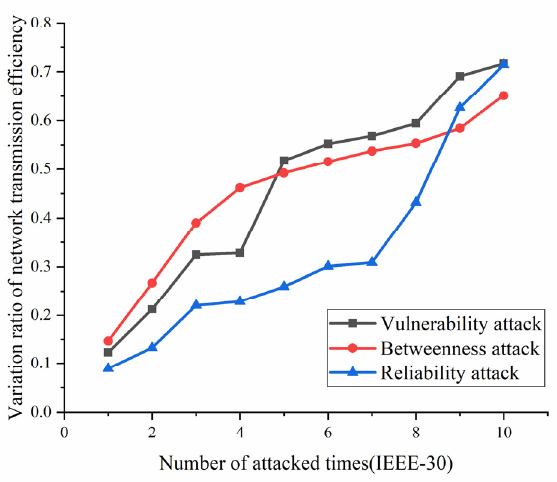
Figure 22. Variation ratio of network transmission efficiency of IEEE-30 bus system under extreme weather.